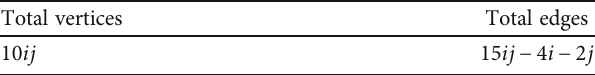
Table 3: Cardinality of nodes and edges for SiC Total vertices